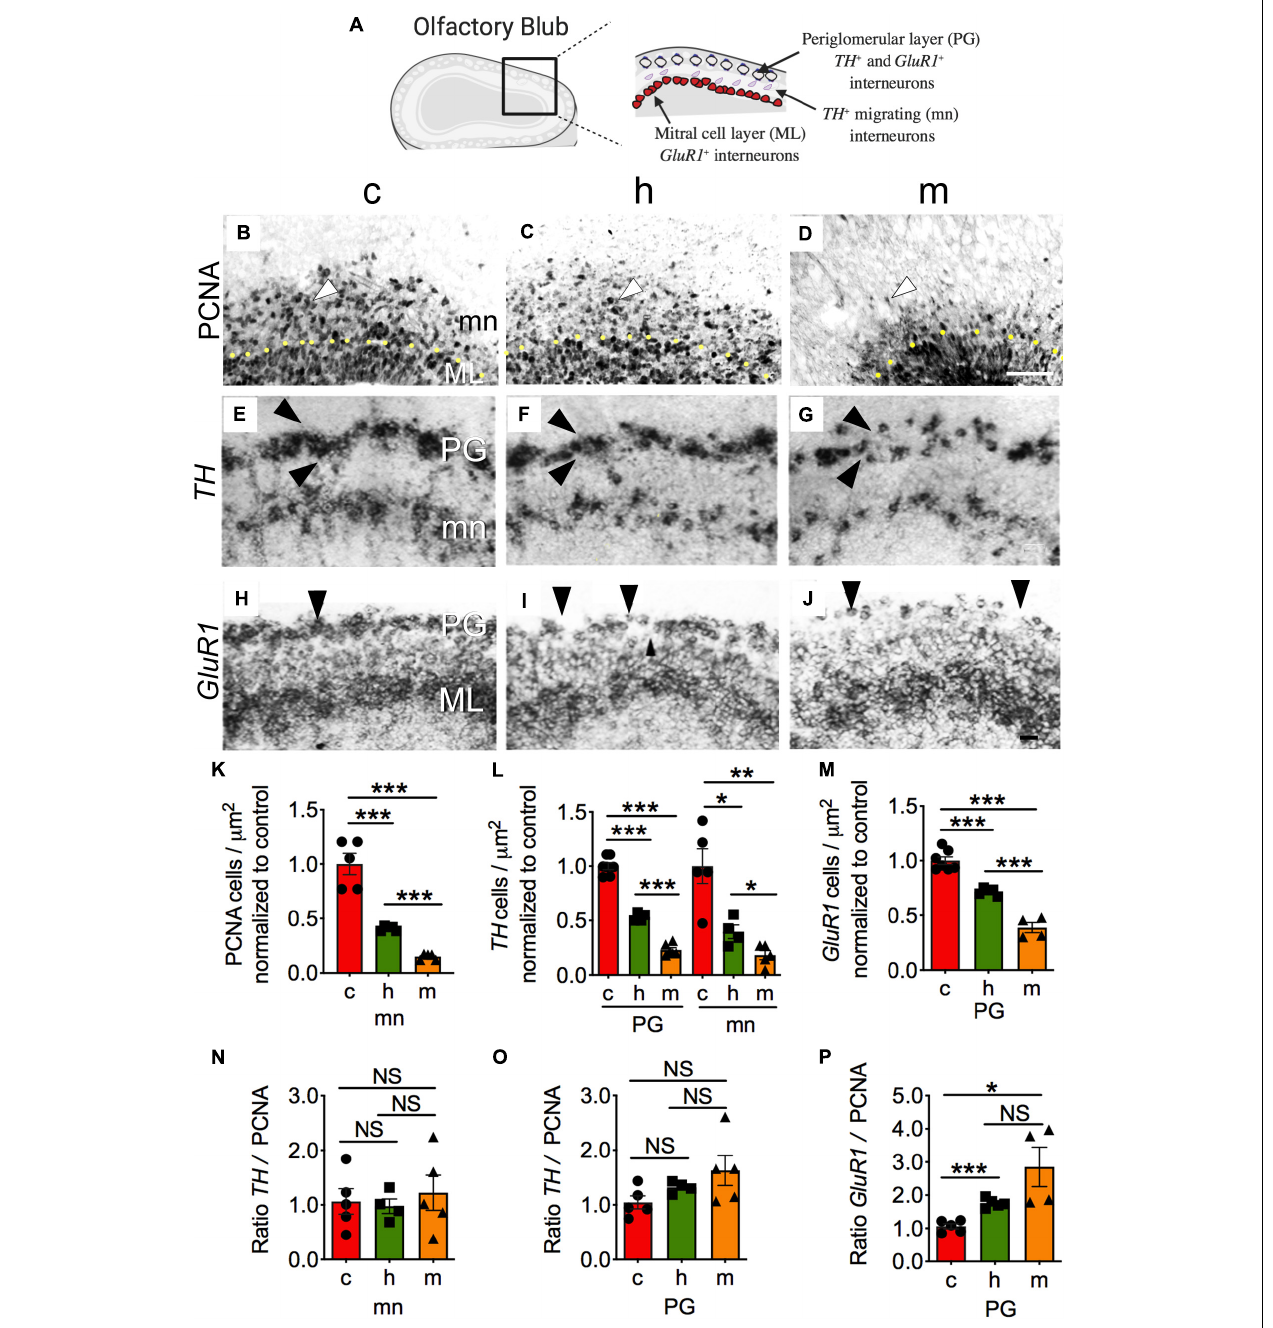
FIGURE 6 | Loss of Jag1 shows defects in periglomerular interneurons. (A) Schematic cartoon of the OB. (B–D,K) Immunolabeling with anti-PCNA antibody on sagittal brain sections shows reduction of PCNA + cells (arrowheads) outside the ML (c, n = 5; h, n = 5; m, n = 5). Scale bar = 100 µ m. PCNA quantification was performed by counting the number of positive cells per micron outside the ML. RNA in situ hybridization using (E–G,L) TH probe shows decreased signal in the PG (c, n = 7; h, n = 4; m, n = 6) and mn (c, n = 5; h, n = 4; m, n = 5) regions. (H–J,M) The number of GluR1 + cells was reduce (c, n = 7; h, n = 5; m, n = 4) in the PG layer (arrowheads); Scale bar = 30 µ m. (N) Calculation of bulbar TH + interneurons (mn) vs. PCNA cells (mn) ratio displays no substantial differences. (O) Normalized ratio of bulbar TH + interneurons (PG) vs. PCNA cells (mn) shows no significant changes. (P) Normalized ratio of GluR1 + interneurons (PG) vs. PCNA cells (mn) shows significant increases in heterozygous and homozygous mice. TH or GluR1 counting was performed using a straight line through the region of interest and counting the number of cells per micron. All sections are coronal. All graphs show average ± SEM. Key to statistics: * p < 0.05; ** p < 0.01; *** p < 0.001, respectively, in comparison to control or heterozygous; NS, not significant. A minimal of four independent embryos was counted for each genotype and one to three sections were selected from each embryo. PG, periglomerular layer; mn, migrating neurons; ML, mitral cell layer.